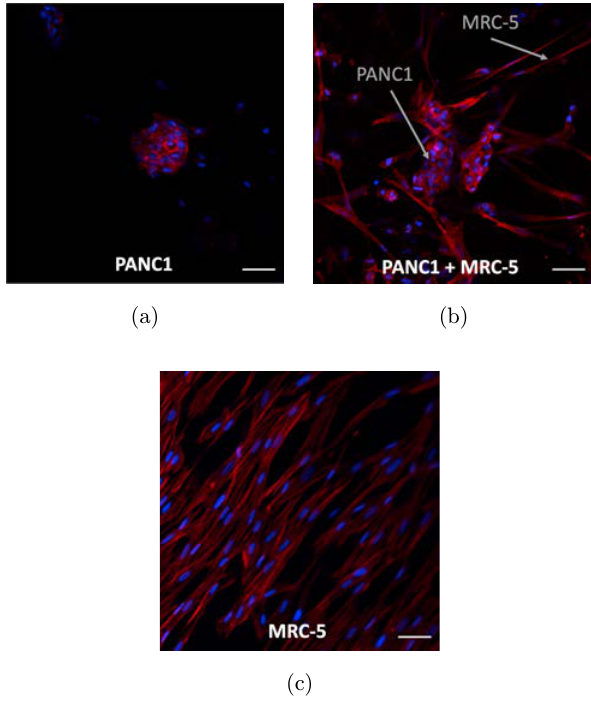
Fig. 2. Confocal images of (a) PANC1, (b) PANC1 and MRC-5 co-culture, and (c) MRC-5 3D cultures. Nuclei are stained with DAPI (blue) and actin is stained with phalloidin (red). Scale bars 50 u